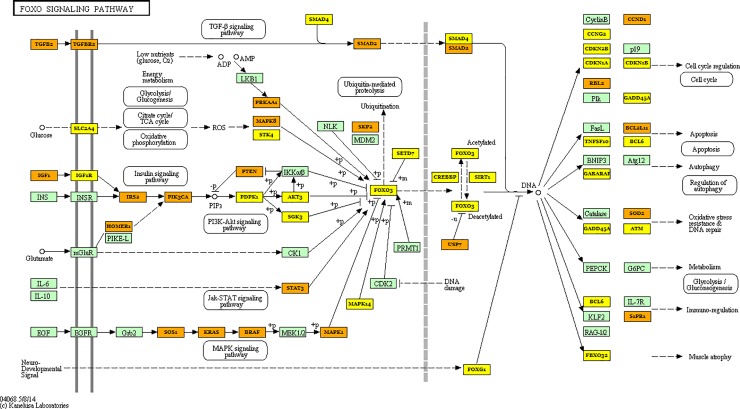
Schematic representation of the FOXO signaling pathway and the target genes of the microRNAs differentially regulated between tumor tissue and healthy tissue from patients diagnosed with colorectal cancer.Yellow box–target gene of one down-regulated miRNA; Orange box–target gene of two or more down-regulated miRNA.